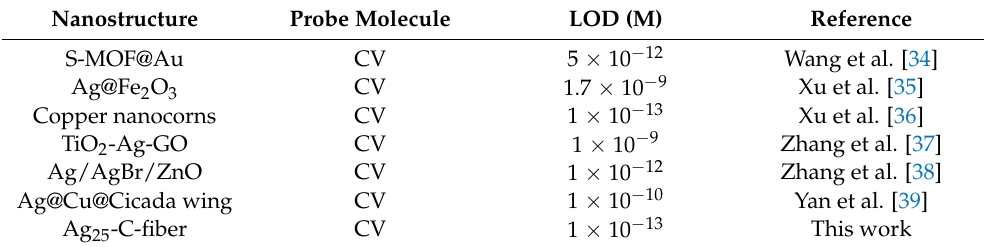
Table 2. LOD for CV on different SERS substrates with different nanostructures reported previously.